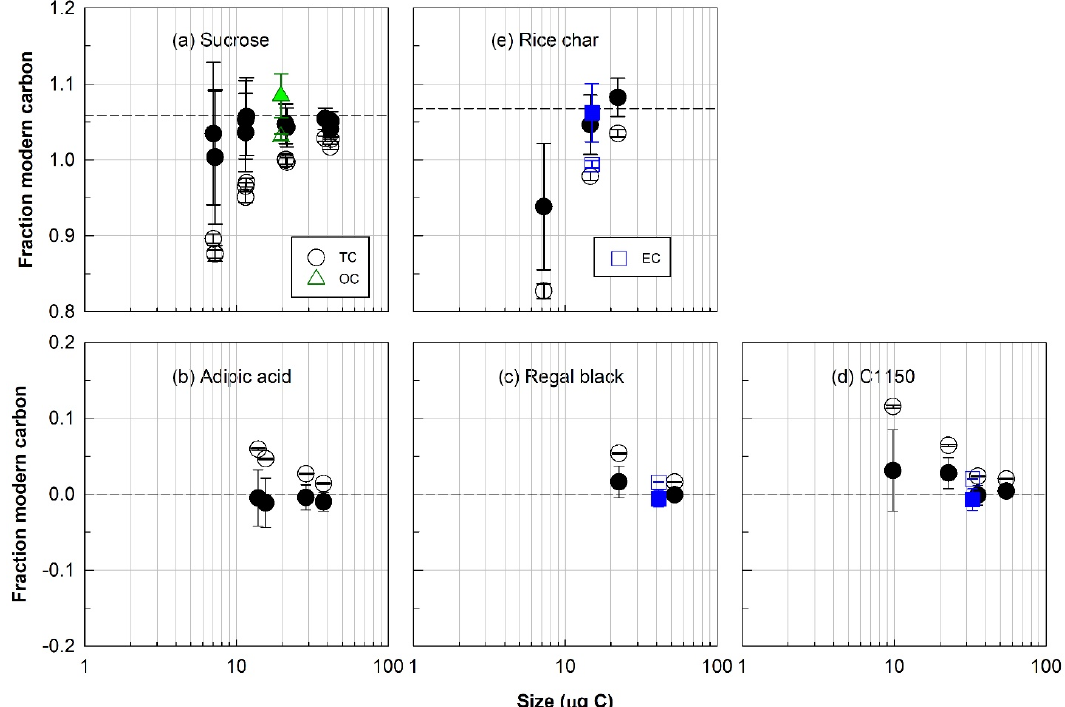
Figure 3. Radiocarbon ( 14 C) compositions, expressed as fraction of modern carbon, total carbon (TC, circles), organic carbon (OC, triangles), and elemental carbon (EC, squares) isolated with the ECT9 protocol from individual modern or fossil reference materials. (a) Sucrose and (b) adipic acid are modern and fossil OC, respectively; (c) regal black and (d) C1150 are fossil EC; and (e) rice char is a mixture of modern OC and EC. Open and solid symbols represent 14 C data before and after correction for extraneous carbon introduced during OC / EC isolation and subsequent 14 C analysis, respectively. The dashed line indicates the consensus value determined from regular-sized bulk samples of these materials undergoing offline combustions (see Table